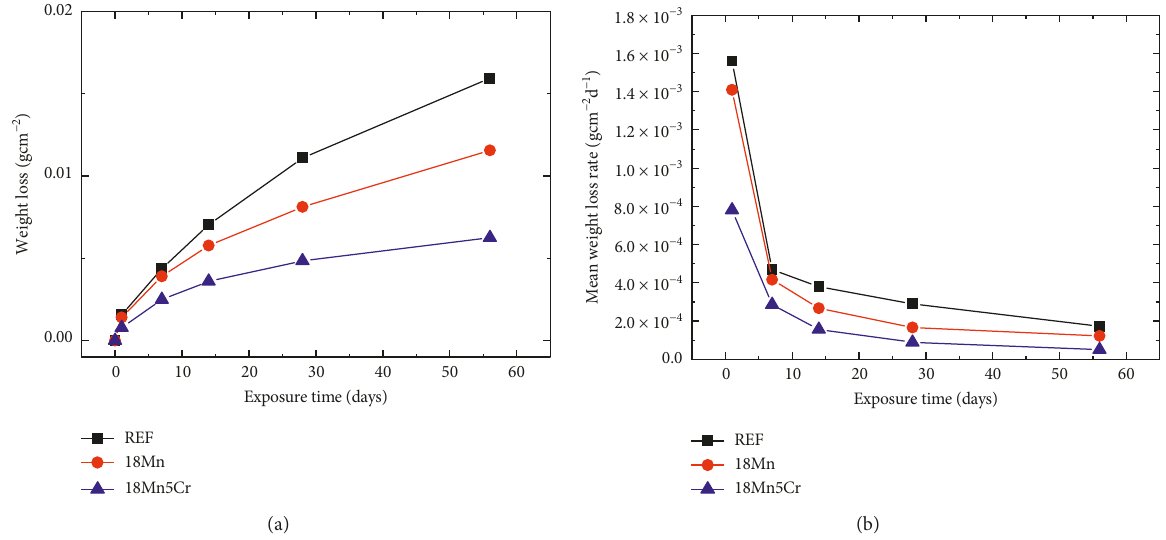
Figure 1: Weight loss versus time curves (a) and average weight loss rate versus time curves (b) of experimental alloys immersed in 3.5% NaCl solution at 60 ° C.